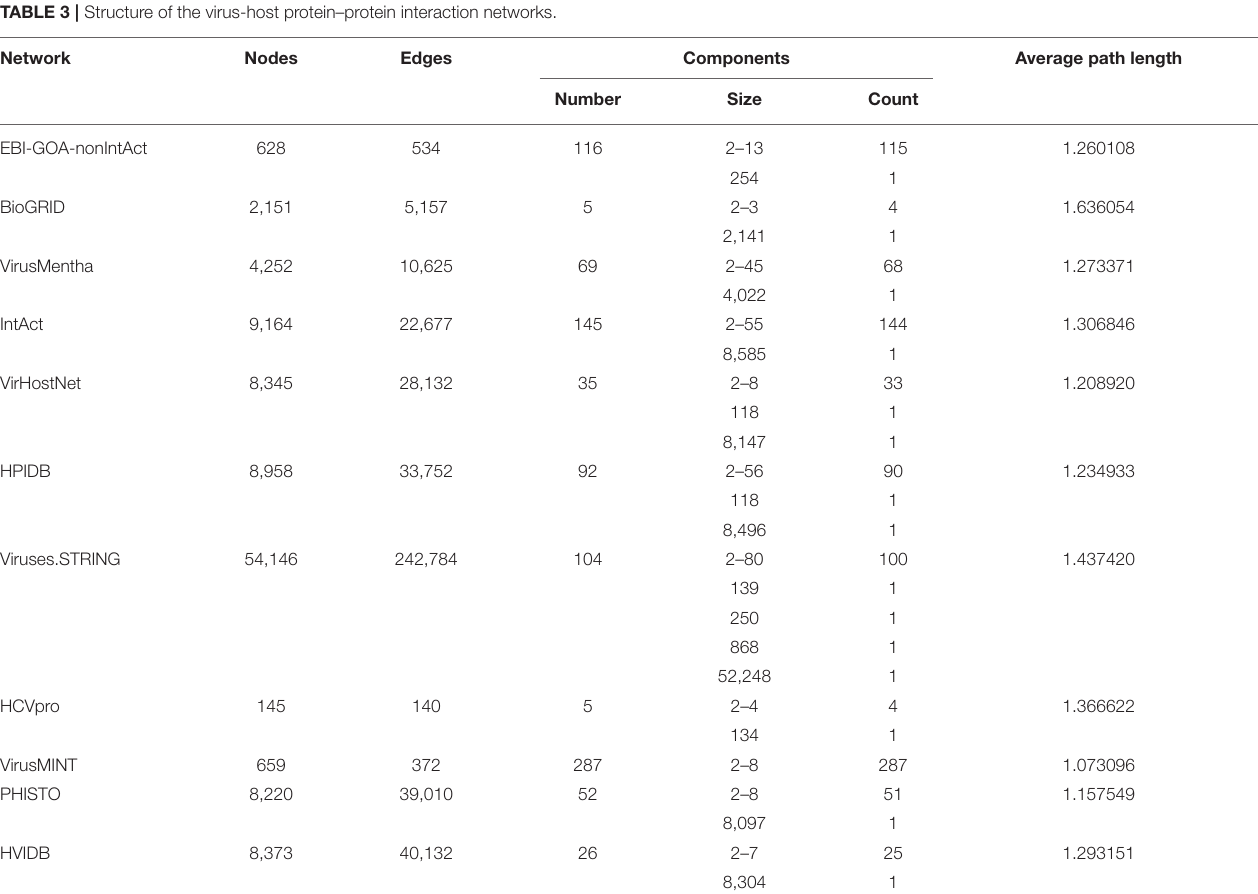
TABLE 3 | Structure of the virus-host protein–protein interaction networks.